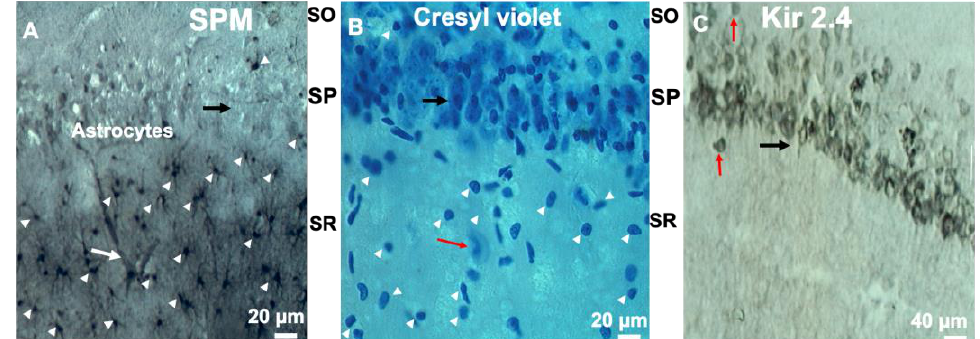
Figure 1. Localization of SPM in astrocytes and Kir 2.4 in neurons in CA1 hippocampus. ( A ) Im- munocytochemical visualization of spermine/spermidine (SPM/SPD) accumulation in astrocytes (white arrowheads). Black arrow indicates the pyramidal cell area showing that pyramidal cells are not accumulating SPM and stay transparent. White arrow points to a blood vessel enwrapped by fine-astrocytic processes. ( B ) Staining with cresyl violet shows all cells (neurons and astrocytes) in the CA1 area of hippocampus. White arrowheads show small cells, likely astrocytes. Red arrow points to large interneuron. ( C ) Red arrows show interneurons, whereas black arrows show pyram- idal cells. The neuronal channel Kir2.4 is localized in neurons. SO, SP, and SR are stratum oriens, pyramidale, and radiatum, respectively. Note: most of the patch-clamp recordings ignore the fact that the astrocytic cytoplasm contains SPM.